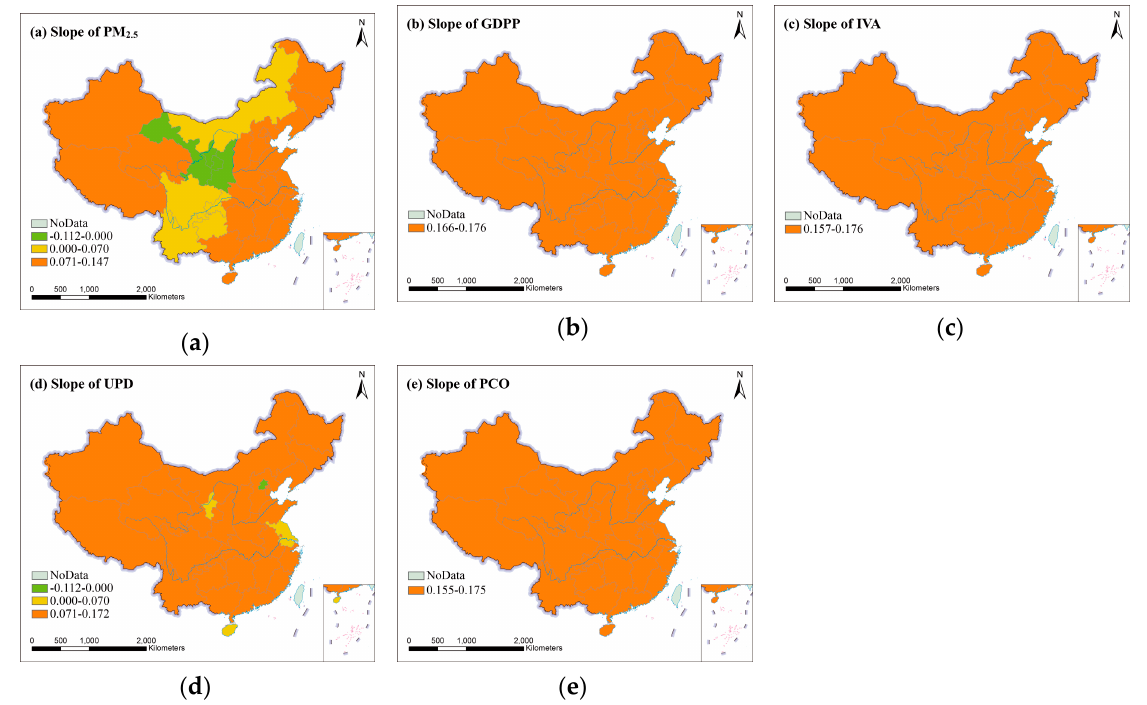
Figure 5. The slope of ( a ) PM 2.5 , ( b ) GDPP, ( c ) IVA, ( d ) UPD and ( e ) PCO from 1998 to 2016.